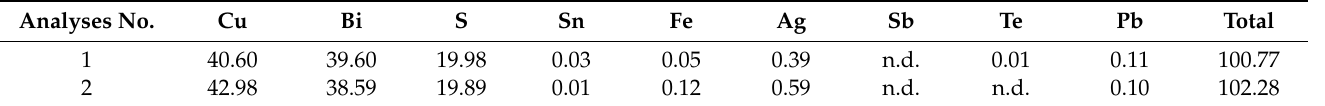
Table 5. Electron microprobe analyses for wittichenite